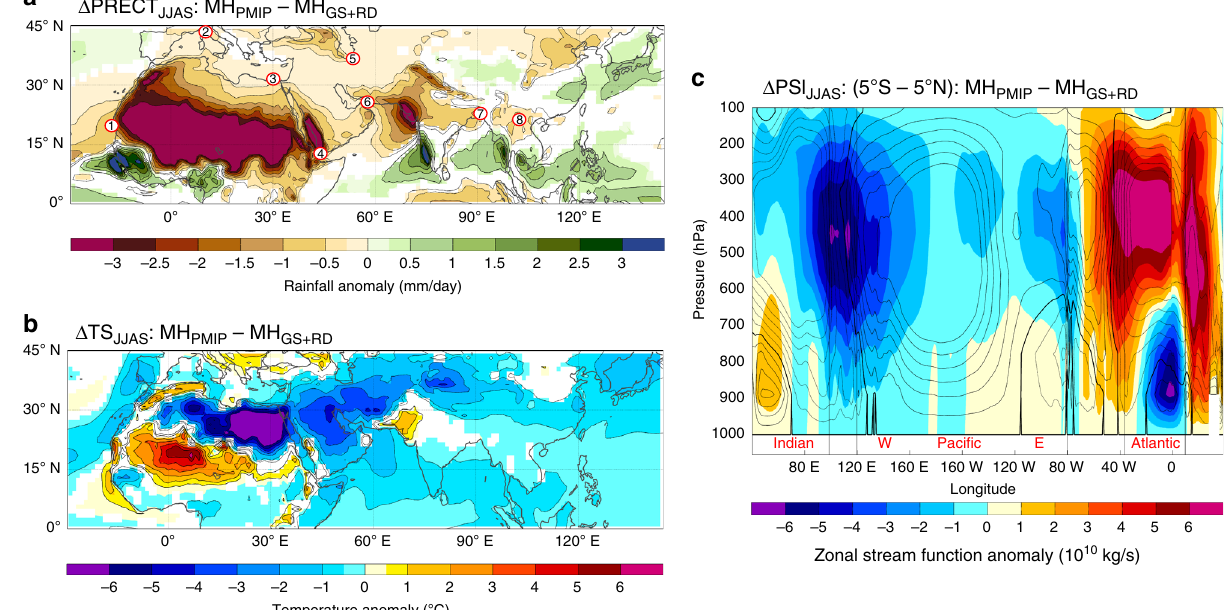
Fig. 5 Changes in precipitation, temperature, and Walker circulation between dry and wet Sahara. a Changes in precipitation, b surface temperature, and c zonal stream function of the Walker circulation (contour lines indicate PI climatology with a contour interval of 2 × 10 10 Kgs − 1 from − 14 to 14 Kgs − 1 ; 0 line in bold) for JJAS in the MH PMIP simulation relative to MH GS + RD . Shaded regions indicate signi fi cant values at the 95% level using a two-sided t -test. Red circles in panel a denote published proxy records showing a drying trend between 5 and 4 ka: 1, West African Margin 2 ; 2, Buca della Ranella 34 ; 3, Nile River Delta 42 ; 4, Gulf of Aden 3 ; 5, Gol-e Zard 7 ; 6, Gulf of Oman 33 ; 7, Mawmluh Cave 8 ; 8, Tham Doun Mai (this